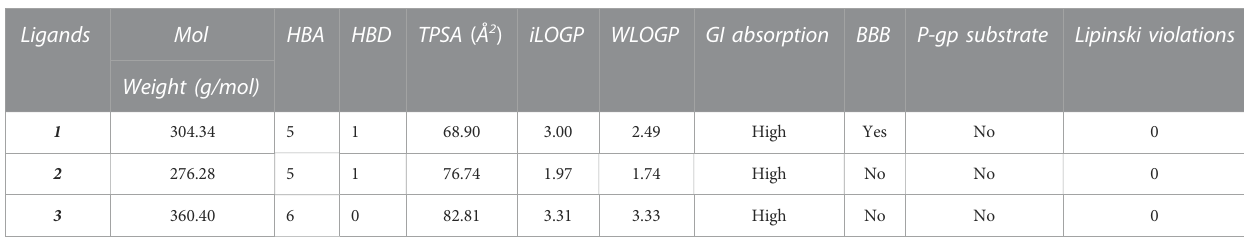
TABLE 2 Predicted ADME pro fi le of tested coumarin derivatives (1 – 3 ).